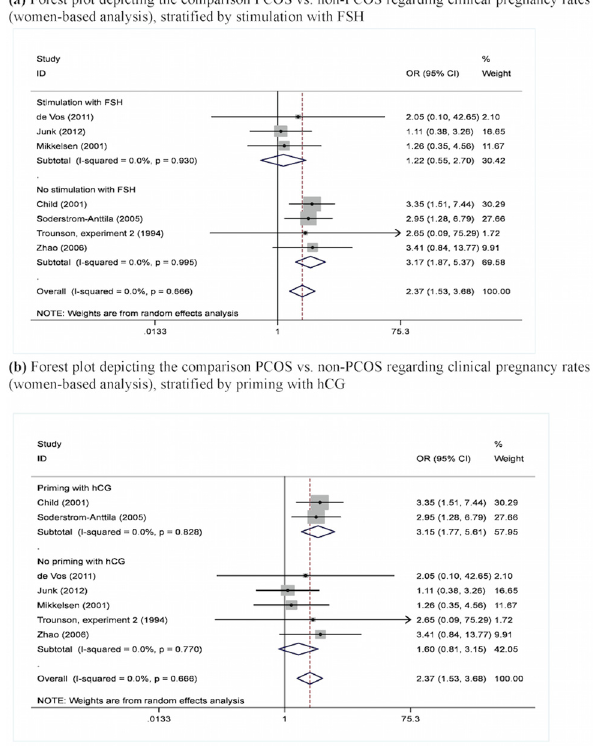
Fig 3. (a). Comparison PCOS vs. non-PCOS regarding clinical pregnancy rates (women-based analysis), stratified by stimulation with FSH. (b) Comparison PCOS vs. non-PCOS regarding clinical pregnancy rates (women-based analysis), stratified by priming with